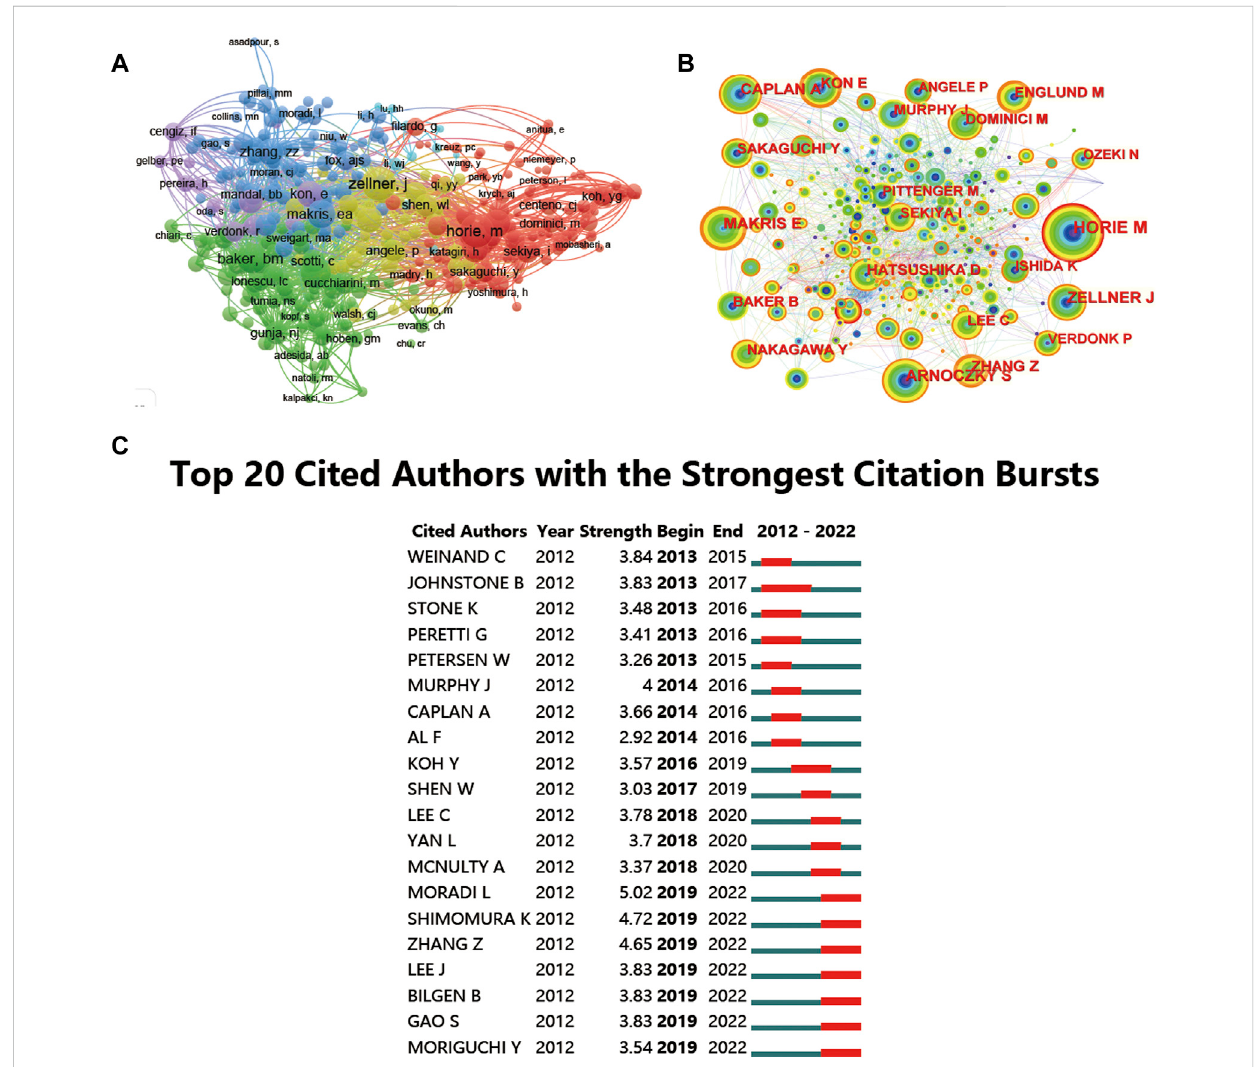
FIGURE 7 CiteSpace network visualization of cocitation author analysis regarding stem cells for meniscus regeneration. Author cocitation analysed by Vosviewer (A) and CiteSpace (B) . (C) Top 25 references with the strongest citation bursts of publications related to stem cells for meniscal regeneration. Author cocitations are indicated by the node. The cocitation relationship is indicated by the line connecting the nodes. The node area grows as the number of cocitations increases. The colors from green to orange represent different years from 2012 to